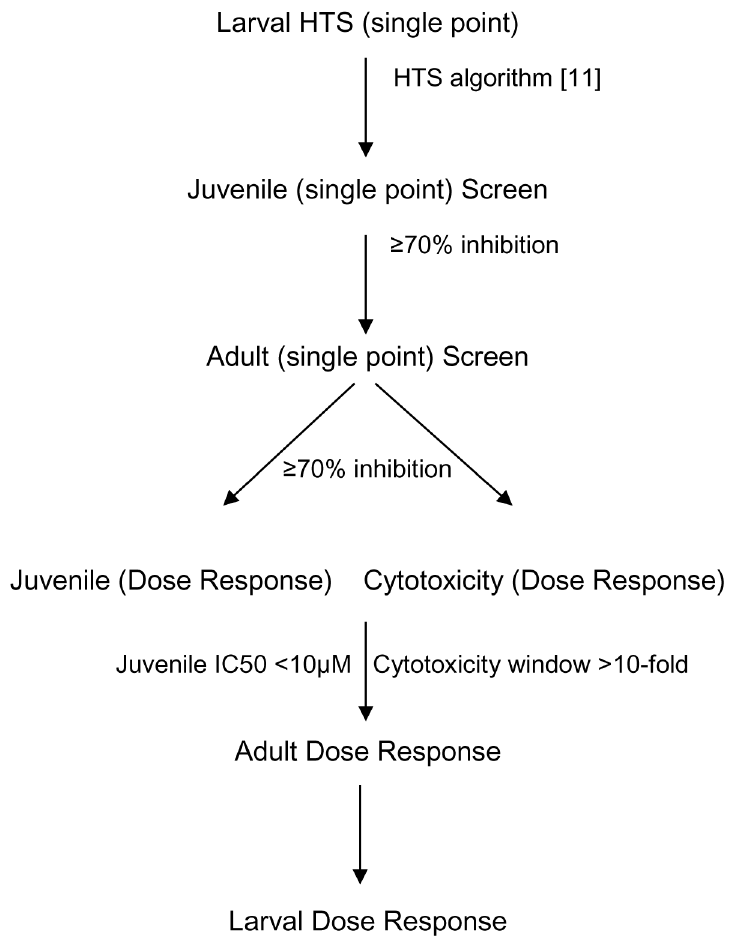
Fig 1. Screening sequence for HTS and follow